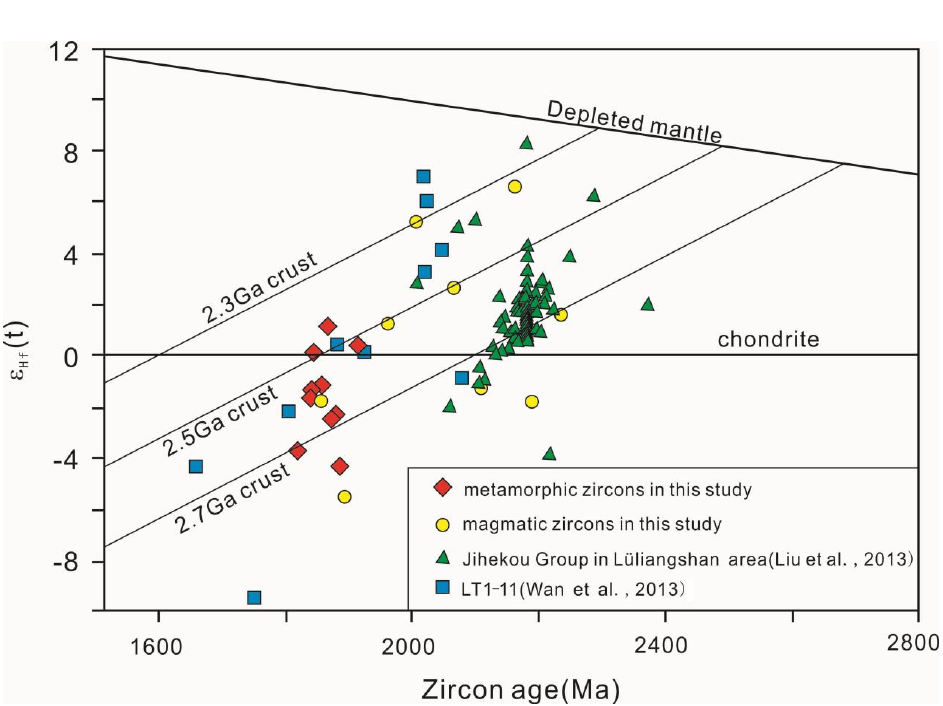
Figure 7. Diagram of ε Hf (t) vs. U-Pb age for zircons from Paleoproterozoic rocks obtained from drill cores beneath the northeastern Ordos Basin and the Lüliangshan area.